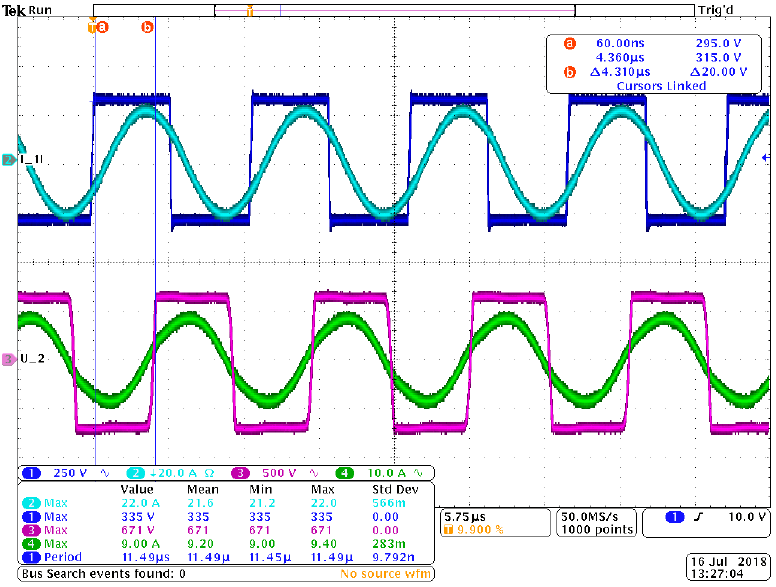
Figure 12. Primary and secondary AC values—voltages and currents.